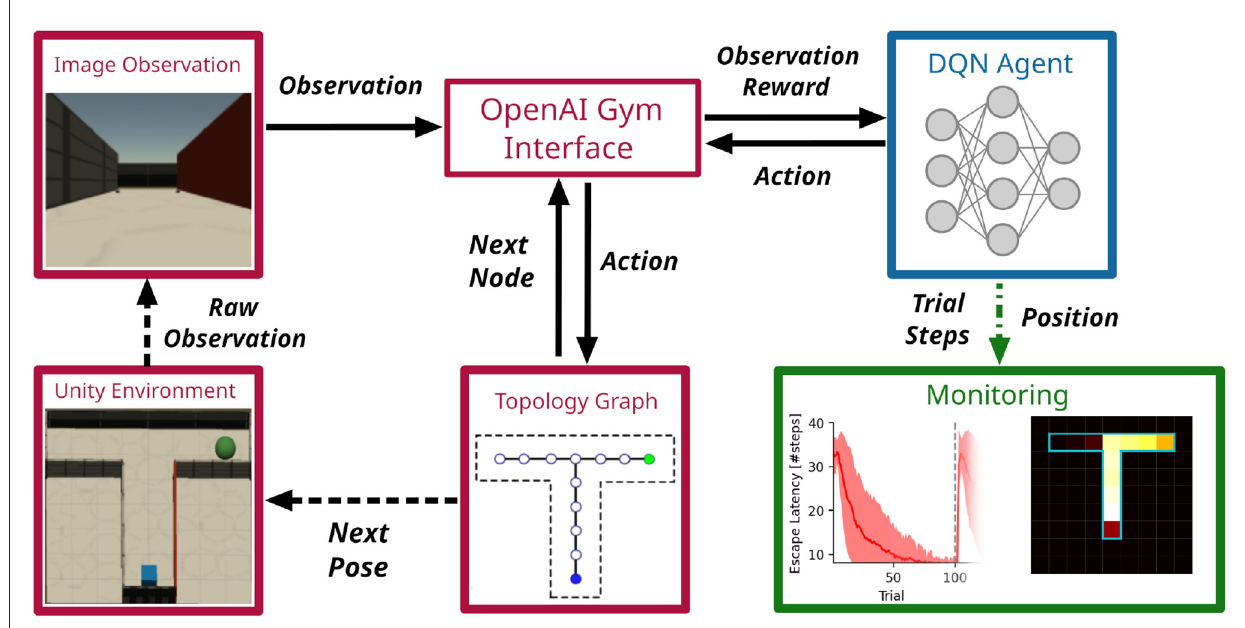
FIGURE2 The CoBeL-RL framework in use. Example of a simulation loop employing a DQN agent in a virtual 3D environment with visual stimuli. Simulation relevant variables are passed between CoBeL-RL’s modules directly (solid arrows) and via web sockets between CoBeL-RL and the 3D simulator (dashed arrows). The monitor modules rely on callback to record variables of interest (dashed green